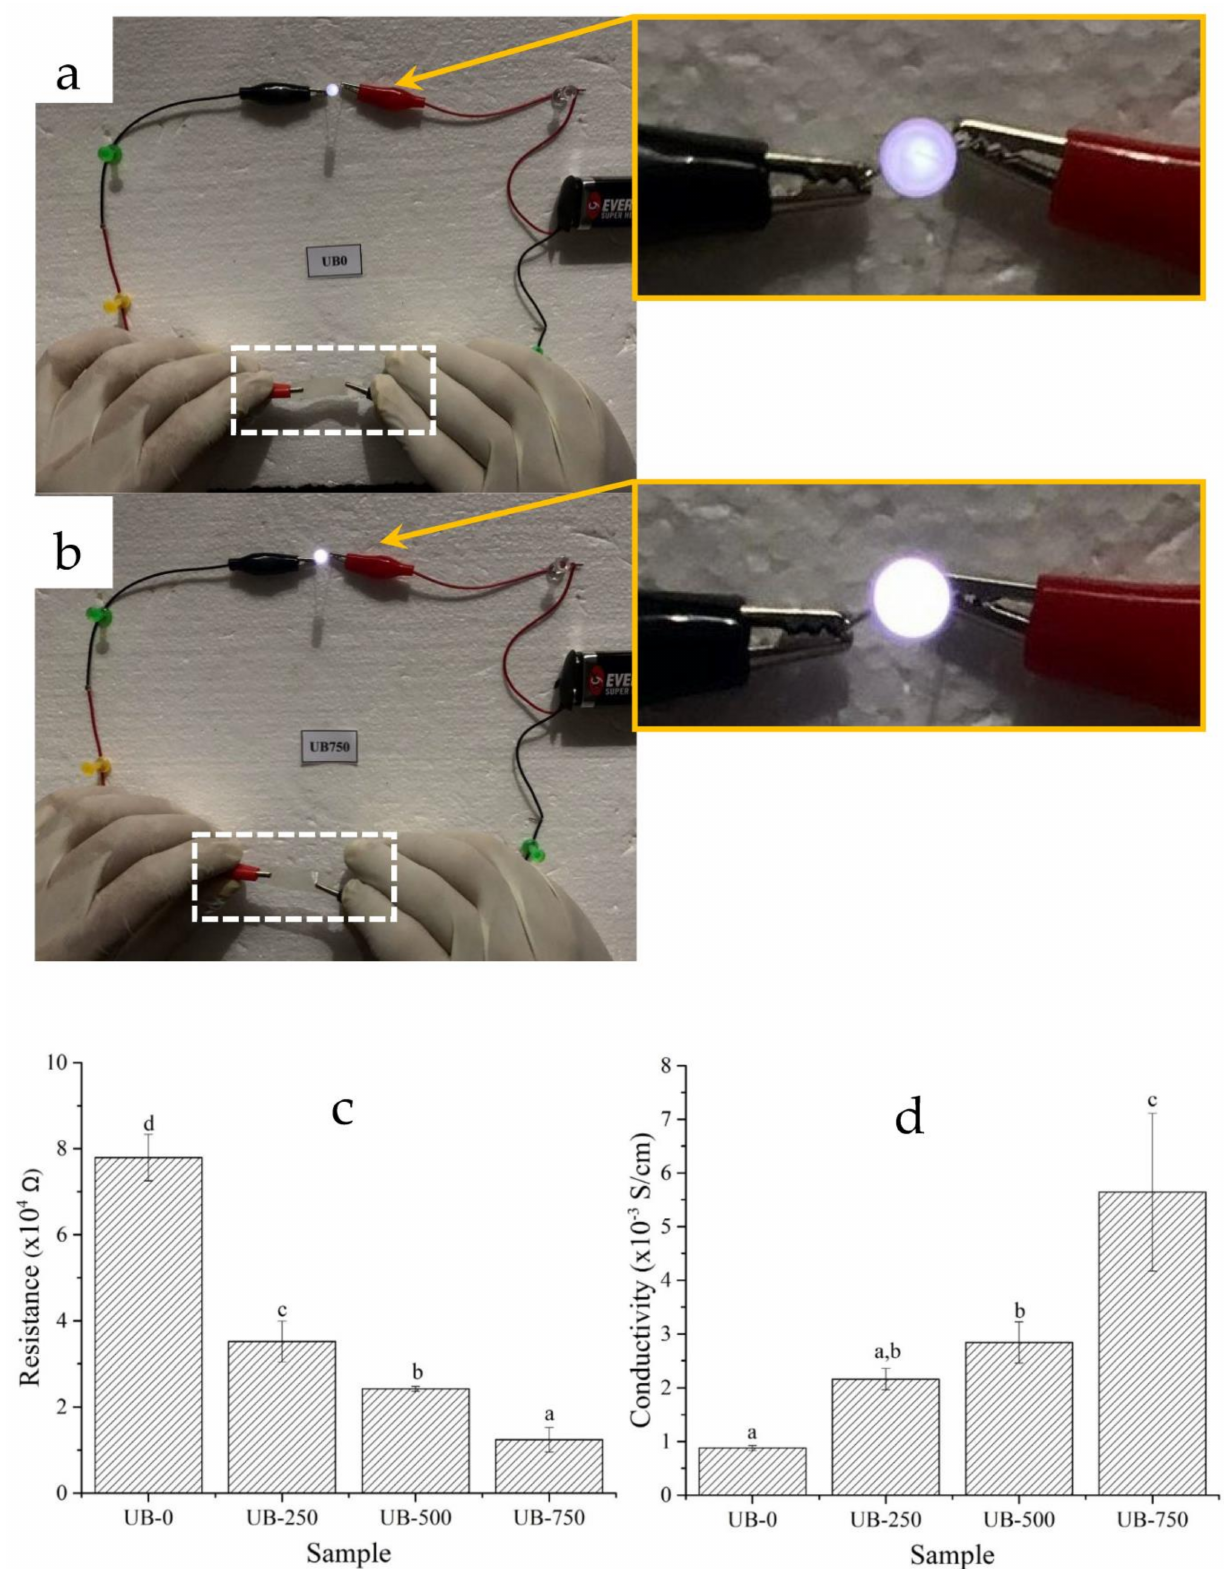
Figure 7. The light-emitting diodes (LED, 3 V) connected with UB-0 ( a ) and UB-750 ( b ) films with a thickness of 32 µ m and 31 µ m, respectively. The electrical resistance ( c ) and conductivity ( d ) values of the nonsonicated (UG-0) and sonicated (UG-250, UB-500, and UG-750) films at 50% RH. Different letters (a,b,c,d) for each data point indicate a significant difference in mean values ( p ≤